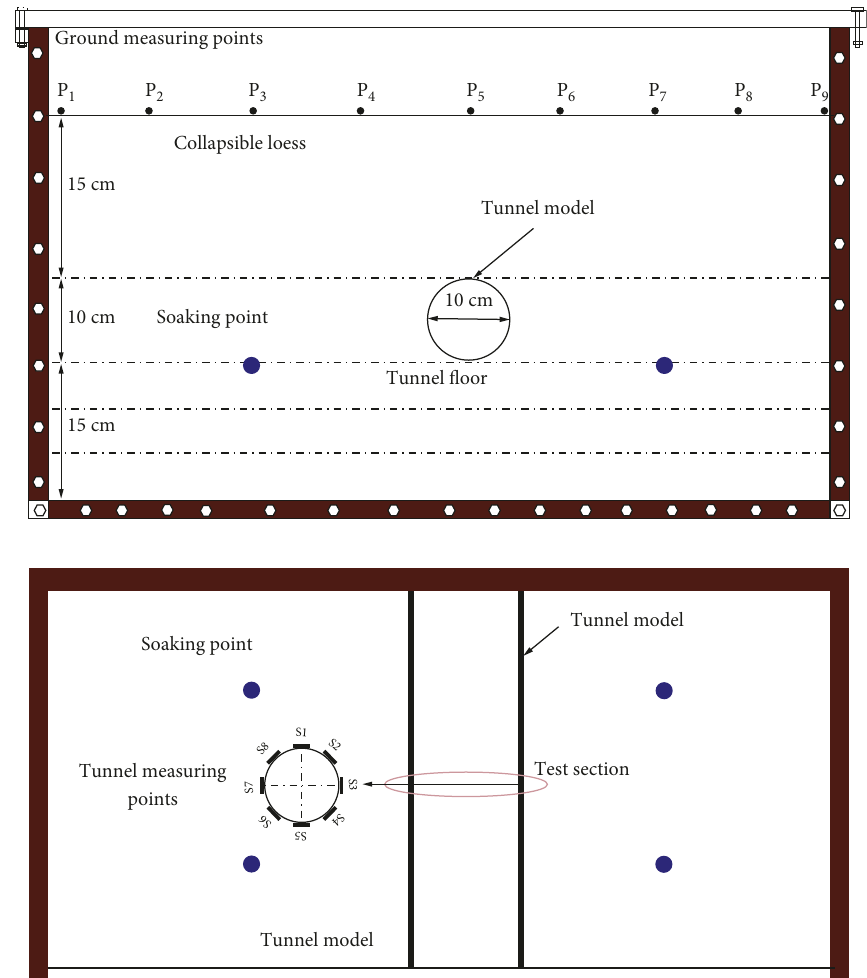
Figure 7: Design of test section and